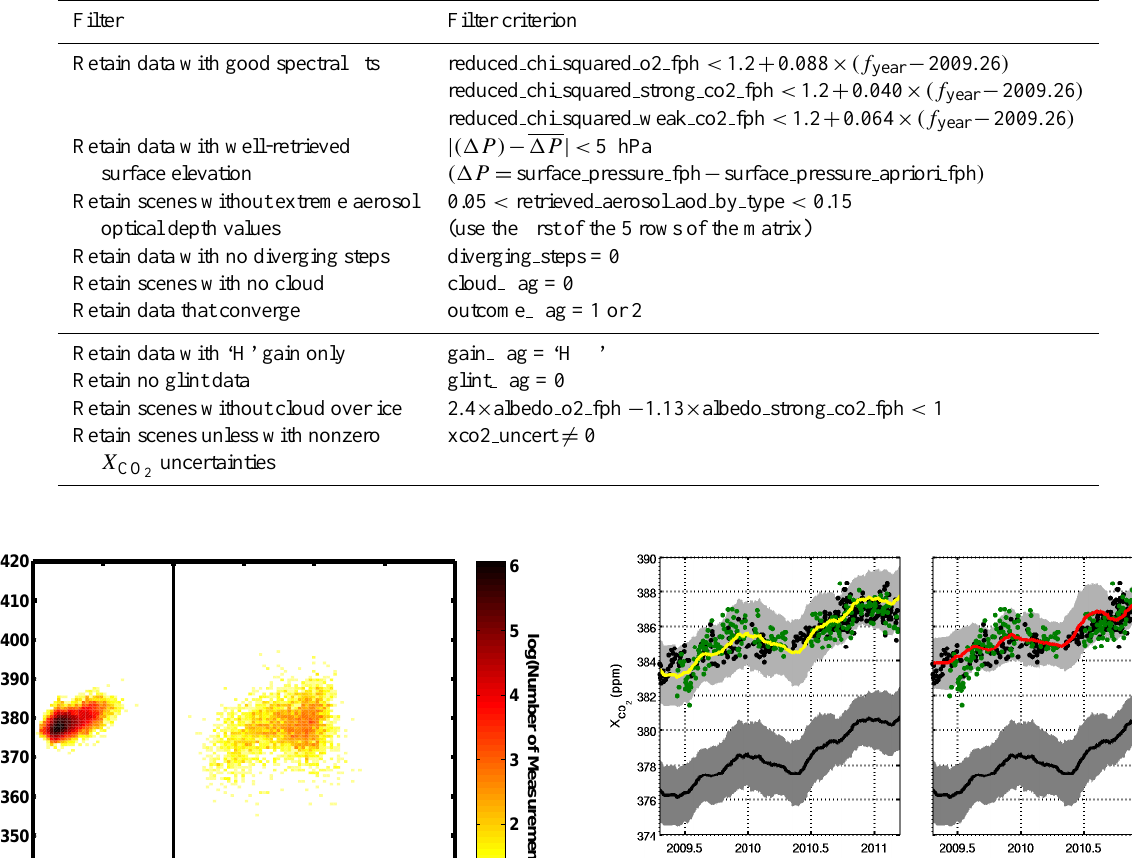
Table 1. Filters applied to the ACOS v2.8 data. The filters that differ from the master quality flag are the χ 2 filter cut-off values, the surface pressure filter and the aerosol optical depth filter. (The quantity f year is the fractional year (i.e., 2009.4). The first GOSAT measurements were recorded on 2009.26.) The additional filters that are not included in the master quality flag are listed below the line. The aerosol optical depth is measured at 0.755µm.